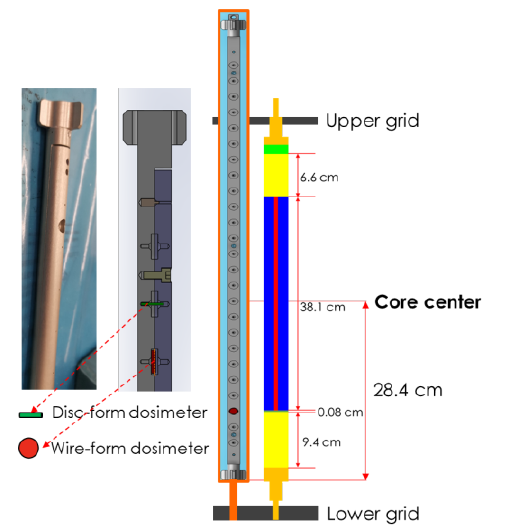
Fig. 6. experimental irradiation device in the core central channel.